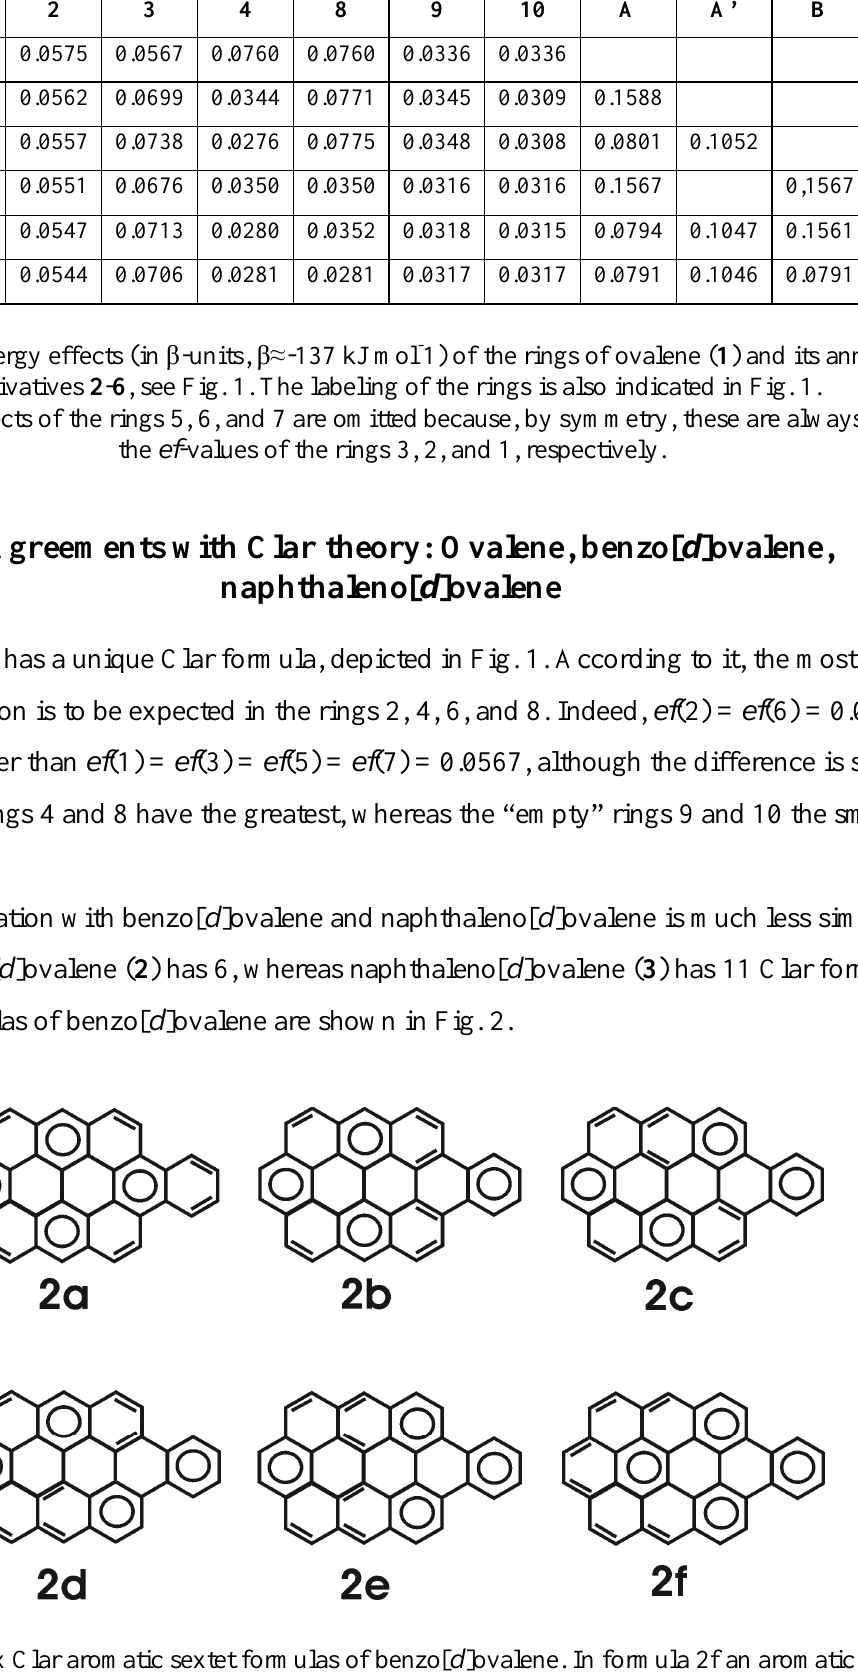
Fig. 2 – The six Clar aromatic sextet formulas of benzo[ d ]ovalene. In formula 2f an aromatic sextet is located in ring 9, whereas no one of these formulas has an aromatic sextet in ring 10. This fact is in good agreement with the increased ef -value of ring 9 and decreased ef -value of ring 10, relative to ovalene